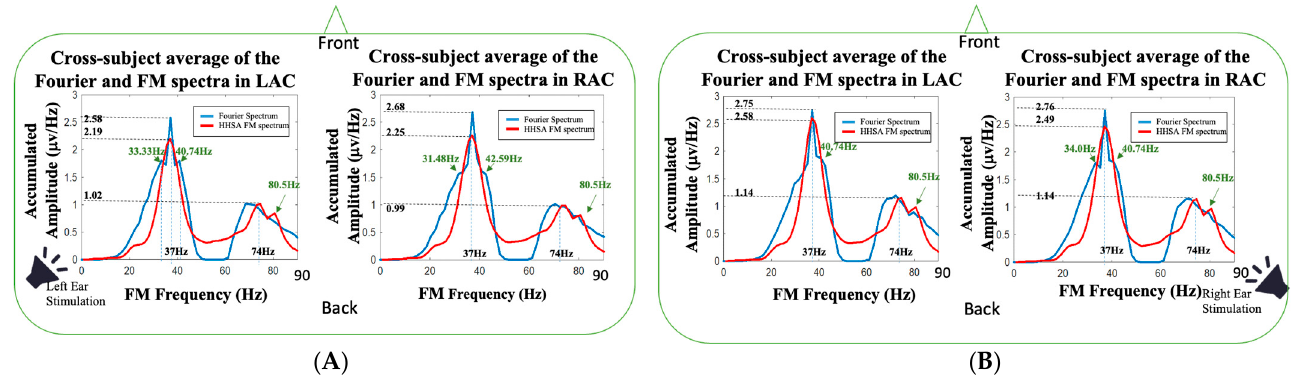
Figure 7. The comparison of the Fourier spectra (marked in blue) and the FM spectra (marked in red) obtained from left-ear and right-ear auditory stimulations: ( A ) the cross-subject averaged spectra obtained from Fourier analysis and the HHSA during left-ear stimulations; ( B ) the cross-subject averaged spectra obtained from Fourier analysis and the HHSA during right-ear stimulations.